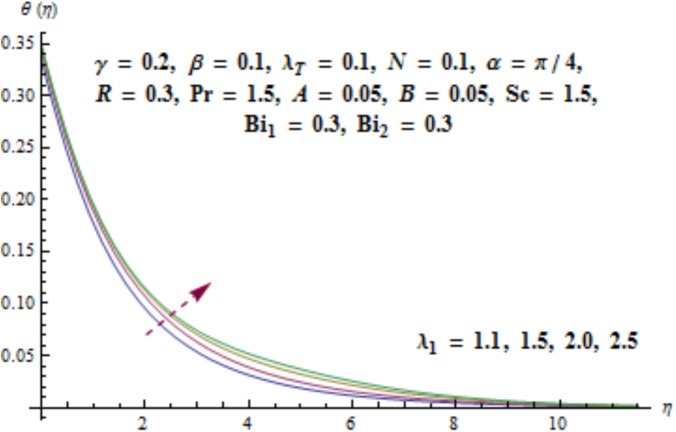
Behavior of λ1 on θ(η).